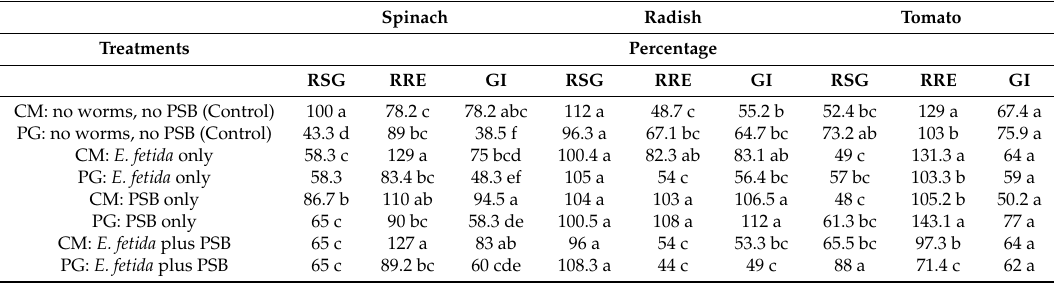
Table 3. The e ff ects of E. fetida and P. fluorescence on the phytotoxicity of rock phosphate enriched cow manure (CM) and pig (PG) manure- waste paper mixtures. Spinach Radish Tomato Treatments Percentage RSG RRE GI RSG RRE GI RSG RRE GI CM: no worms, no PSB (Control) 100 a 78.2 c 78.2 abc 112